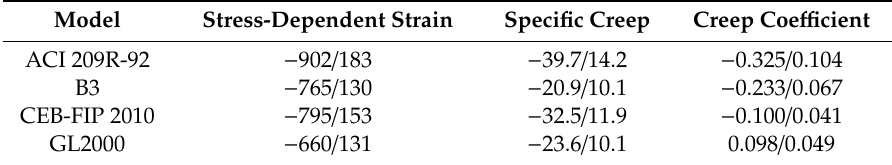
Table 5. The average and standard deviation of residual values by models predicted value minus experimental data value (shown as average / standard deviation). Figure 8. Comparison of creep in AAS concrete based on the model predictions. ( a ) stress- dependent strain; ( b ) specific creep; ( c ) creep coefficient.